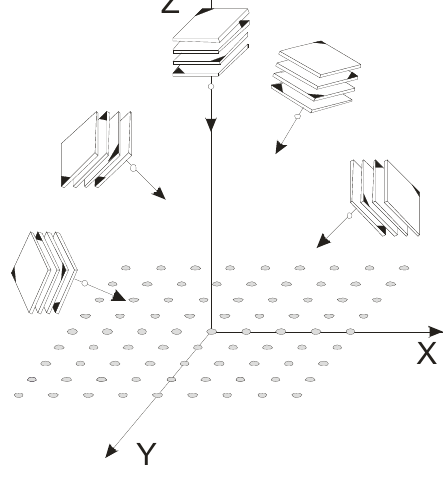
Figure 4. Network configuration of the photogrammetric survey to obtain “true” coordinates (third test for